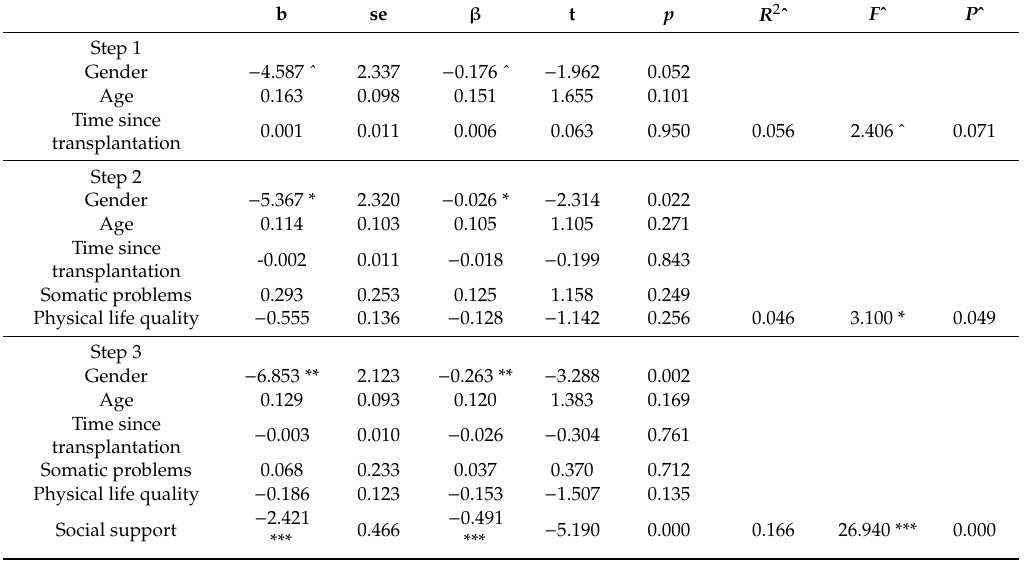
Table 4. Hierarchical regression to predict AD among